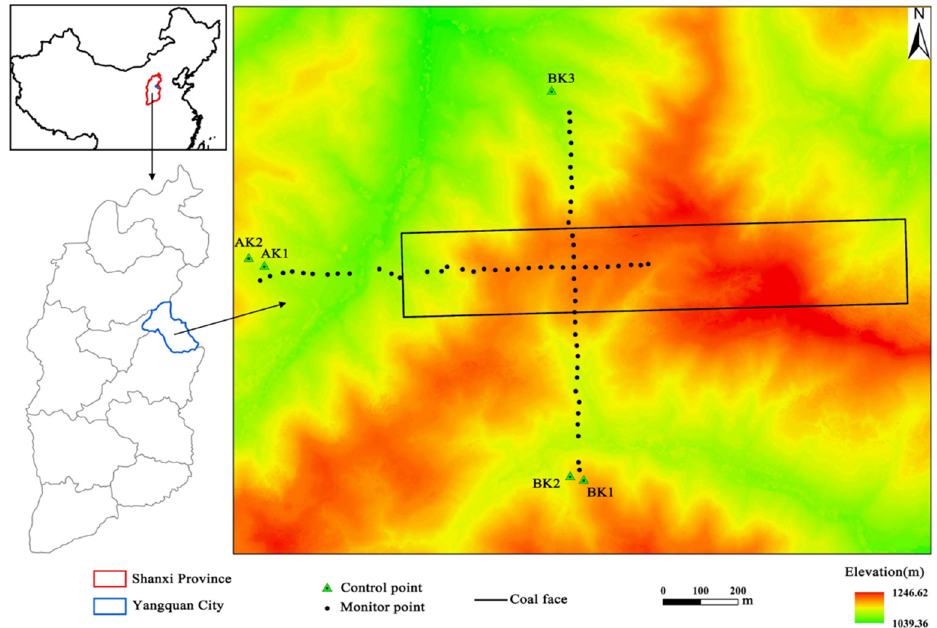
Figure 1. Schematic for relationship between the working face, observation stations, and study area.